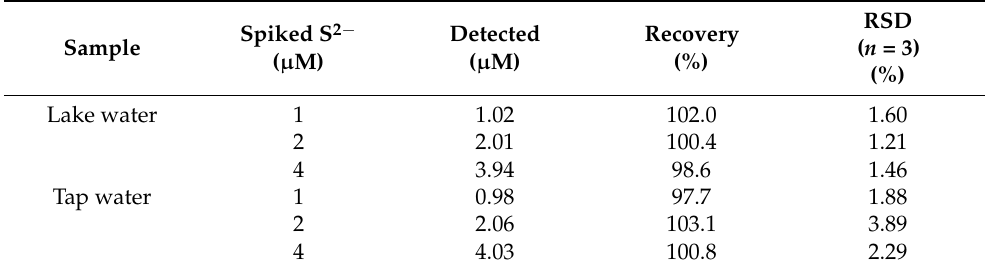
Table 4. Determination of S 2 − in lake water and tap water. ( n is the number of repeated experiments, 95% confidence level, RSD = recovery standard